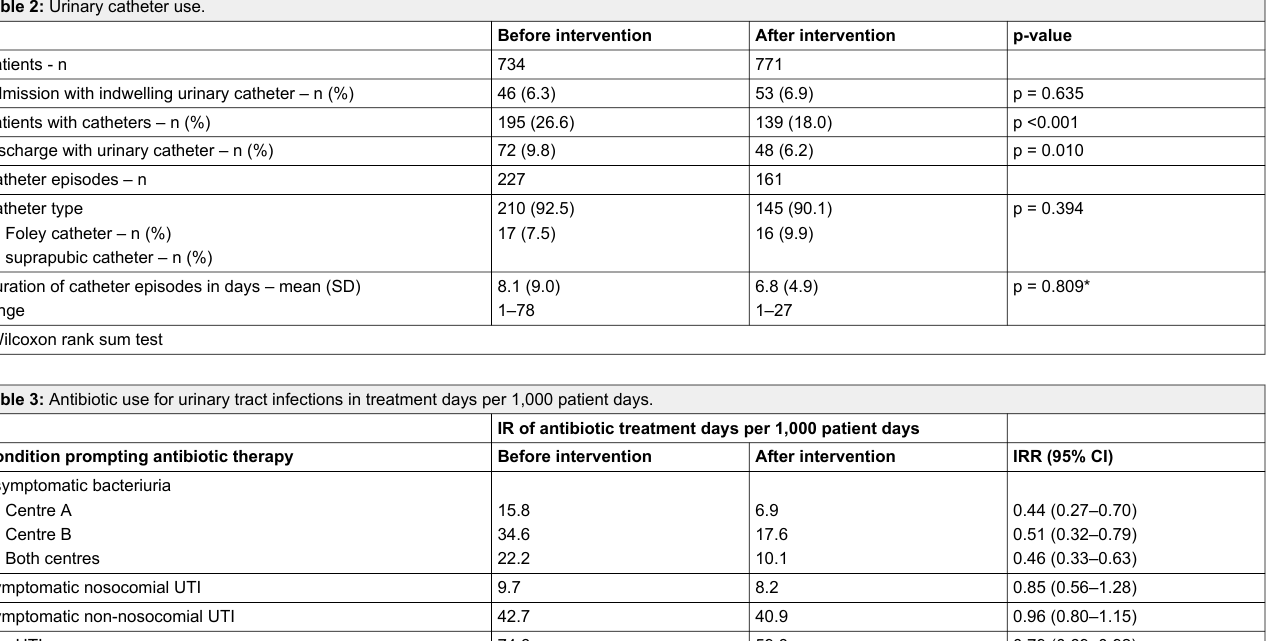
Before intervention After intervention